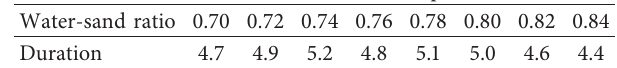
Table 1: Different water-sand ratios correspond to